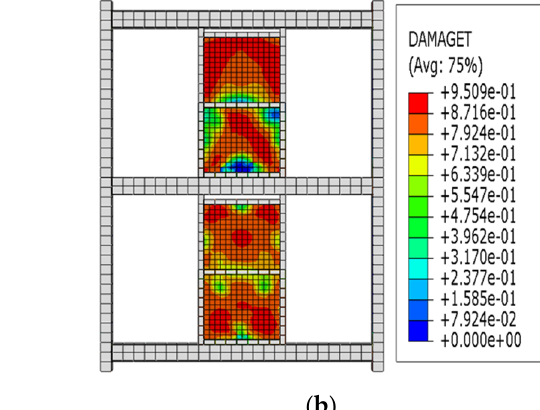
Figure 12. Failure modes of frame F2. ( a ) DAMAGET contour plot of the wall panel element; ( b ) von Mises stress contour plot of the frame.